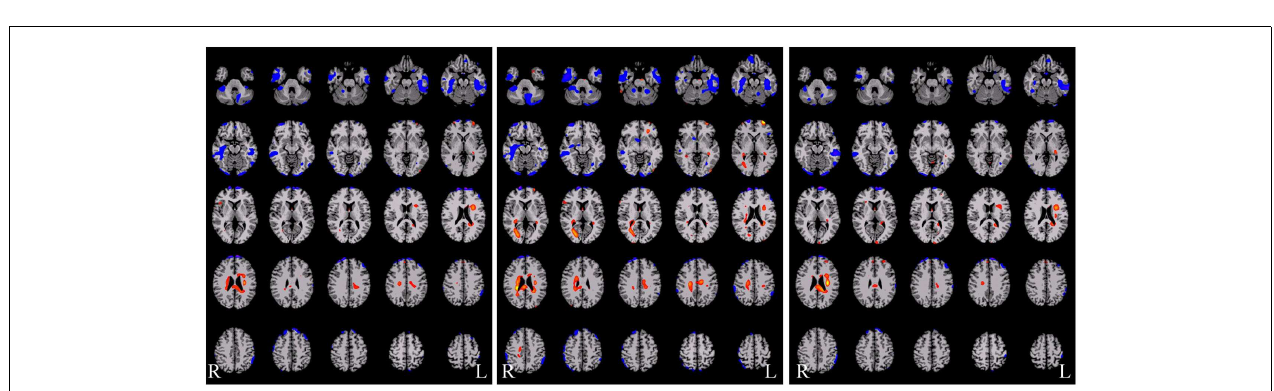
seizure onset zones but clearly a large number of regions show altered connectivity.There are subtle differences between these three measures and more work is needed to determine the sources of these differences and the interactions with different pathological